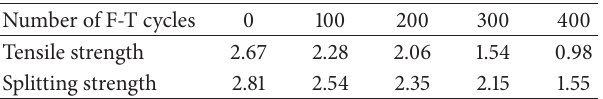
Table 4: The splitting and tensile strength of A-E-C after F-T cycles (MPa).